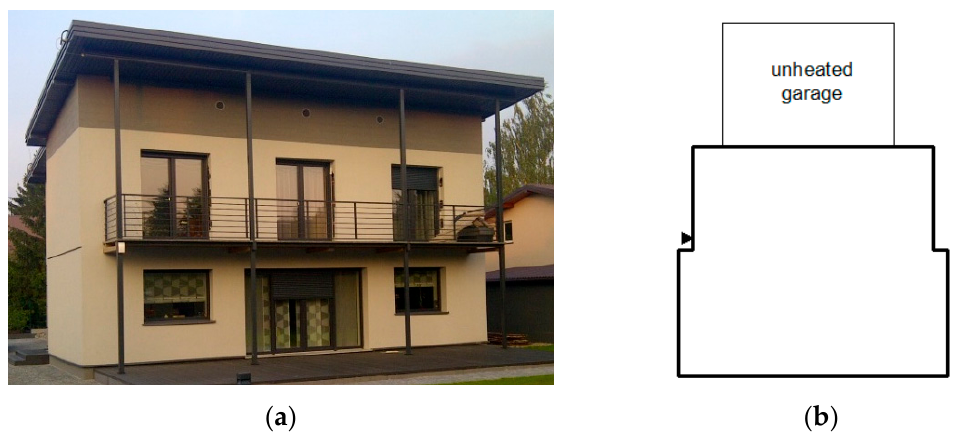
Figure 6. Photographs of the analyzed building: ( a ) south facade of the analyzed single-family building with an additional self-supporting light balcony system made of steel profiles; ( b ) layout of the analyzed building.